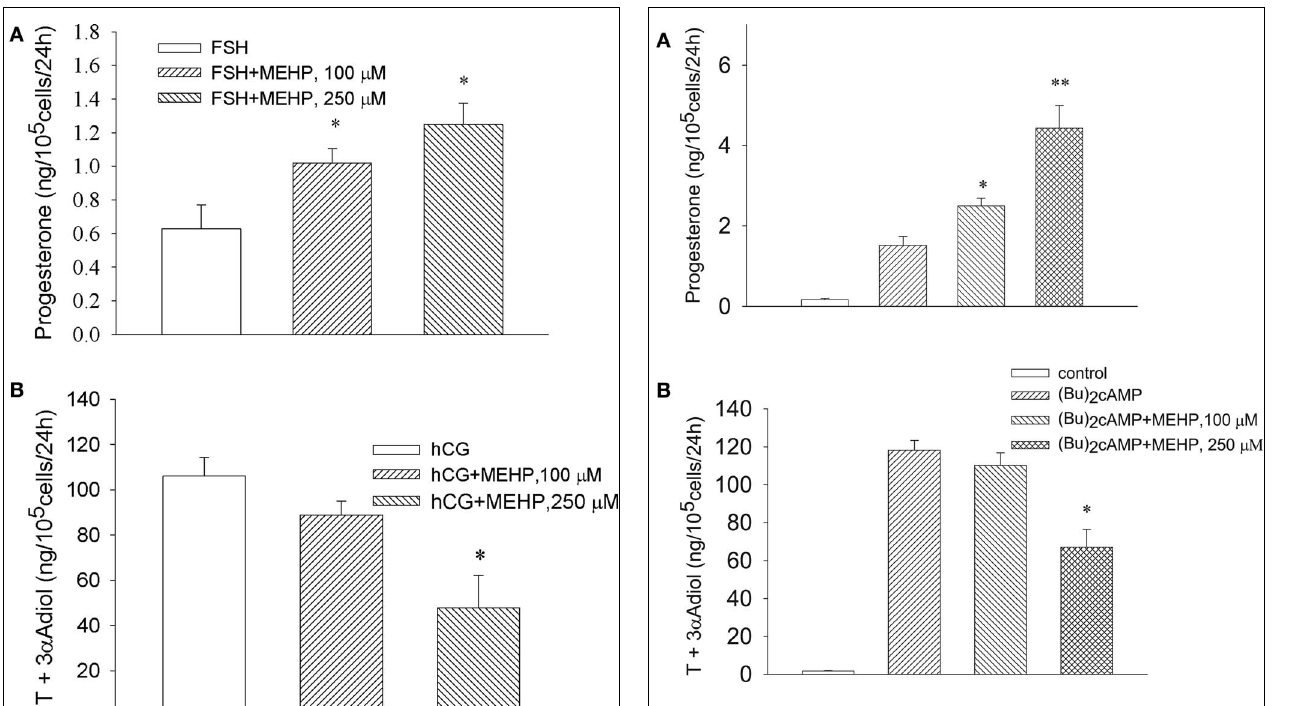
FIGURE 3 | Opposite effect of MEHP on (Bu) 2 cAMP-stimulated steroidogenesis in immature granulosa cells (A) and Leydig cell progenitors (B). The steroidogenic cells were cultured without or with MEHP at different concentrations for 24h and then incubated with (Bu) 2 cAMP (1mM) in the absence or presence of the same concentrations of MEHP for an additional 24h.Testosterone (T), 3 α -Adiol and progesterone in the culture media from the steroidogenic cells were then measured by RIA.The mean values ± SEM for four independent steroidogenic cell preparations are presented. * p < 0.05, ** p < 0.01 compared to treatment with (Bu) 2